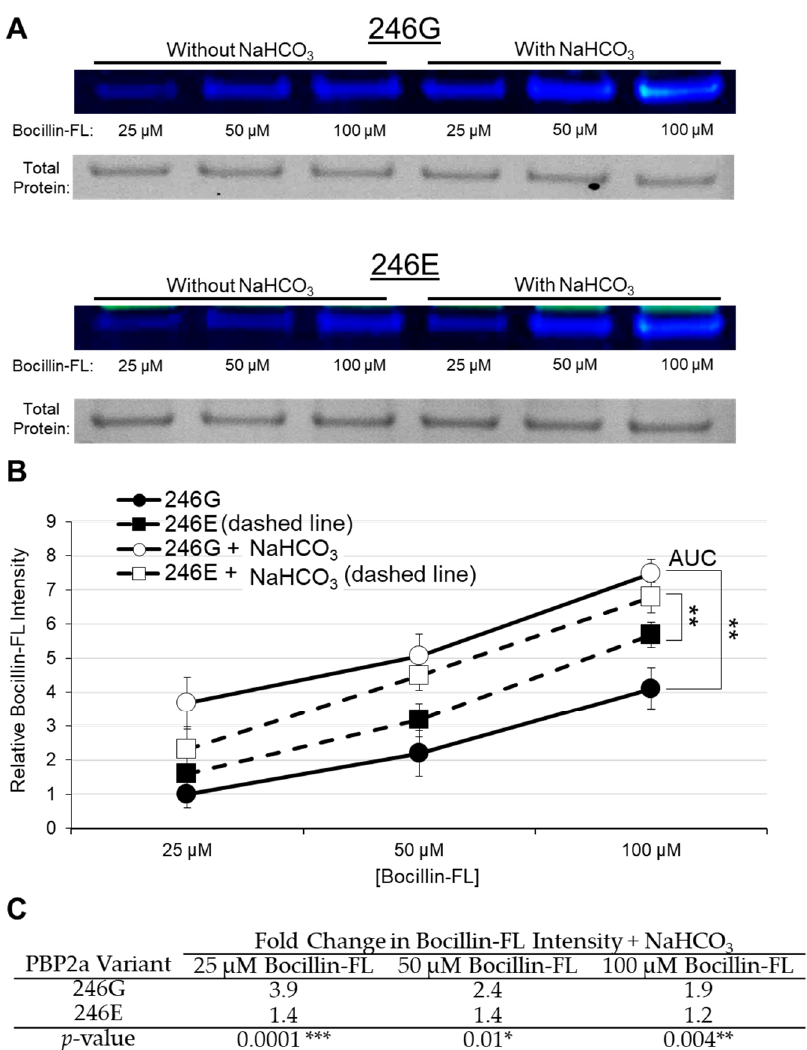
Figure 1. Bocillin-FL binding to purified PBP2a variants 246G and 246E. ( A ) Representative gel images for PBP2a-Bocillin binding and total protein loading; 50 µg/mL PBP2a was incubated with 25, 50, or 100 µM Bocillin-FL in each gel. ( B ) Bocillin-FL binding with and without 44 mM NaHCO 3 ; 50 µg/mL PBP2a was used in each Bocillin binding reaction. Relative Bocillin intensity was determined by normalizing absolute intensity values for each sample to the average intensity of 25 µM Bocillin bound to 50 µg/mL 246G PBP2a in the absence of NaHCO 3 (with this value being set equal to 1.0). Additionally, an intra-gel normalization control was run on each gel consisting of 25 µM Bocillin-FL incubated with 50 µg/mL 246G PBP2a to which all bands were initially normalized. The data presented are the composite of four separate gel runs. Asterisks represent the significant difference in the area under the curve (AUC) for each variant incubated with and without NaHCO 3 (Student’s t- test, ** p < 0.01). ( C ) Fold changes in Bocillin-FL binding to each PBP2a variant in the presence and absence of 44 mM NaHCO 3 (calculated from data in part ( B )). Fold change is calculated as [Bocillin Intensity] NaHCO3 /[Bocillin Intensity] No NaHCO3 . Values greater than 1 indicate increased Bocillin-FL binding to PBP2a in the presence of NaHCO 3 . Statistical significance is calculated using the average fold-change in Bocillin-FL binding for each PBP2a variant in the presence vs. absence of NaHCO 3 by Student’s t -test (* p < 0.05, ** p < 0.01, *** p < 0.001). Next, in parallel studies, NaHCO 3 (44 mM) was added to each of the PBP2a-Bocillin-FL binding reactions. This concentration of NaHCO 3 is the standard used in prior in vitro and ex vivo assays to disclose β -lactam susceptibility and, thus, identify NaHCO 3